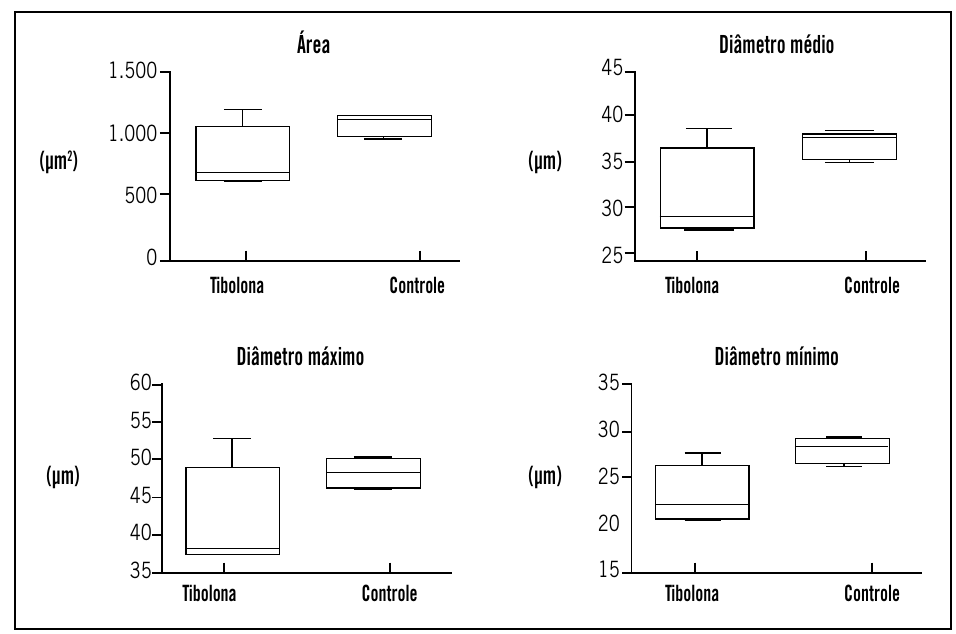
Figura 5 – Histomorfometria de fibras musculares esqueléticas Boxplot a distribuição de dados mostrando a mediana, os quartis e os valores máximo e mínimo. Grupo tibolona ( n = 6) e grupo-controle ( n = 4). Teste de Mann-Whitney p <